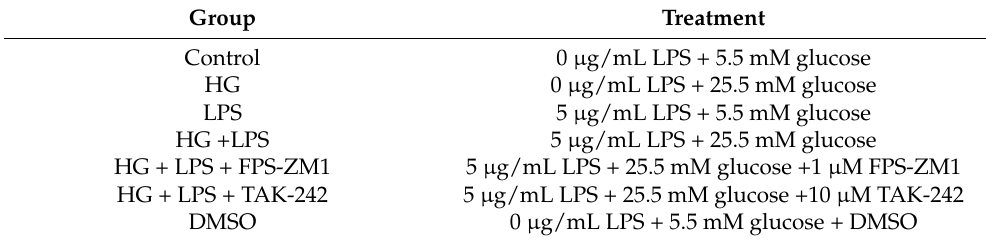
Table 1. Experimental grouping of the combined effects of LPS and HG.